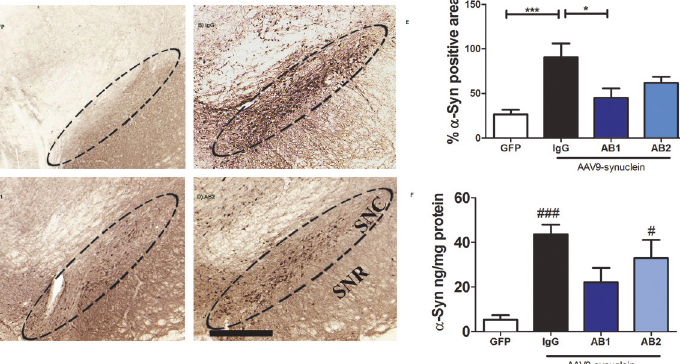
Fig 3. The effect of intraperitoneal administered anti- α -Syn antibodies on AAV vector mediated α -Syn expression. Immunostaining of the SN region with an antibody against α -Syn. Administration of AAV- α -Syn